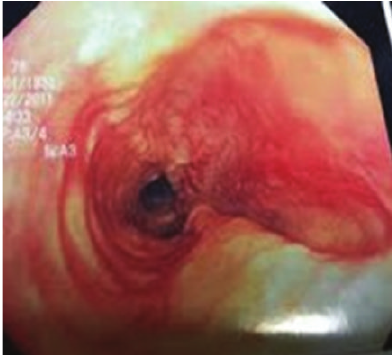
Figure 2: Tracheal tear on posterior wall on intraoperative flexible bronchoscopy.